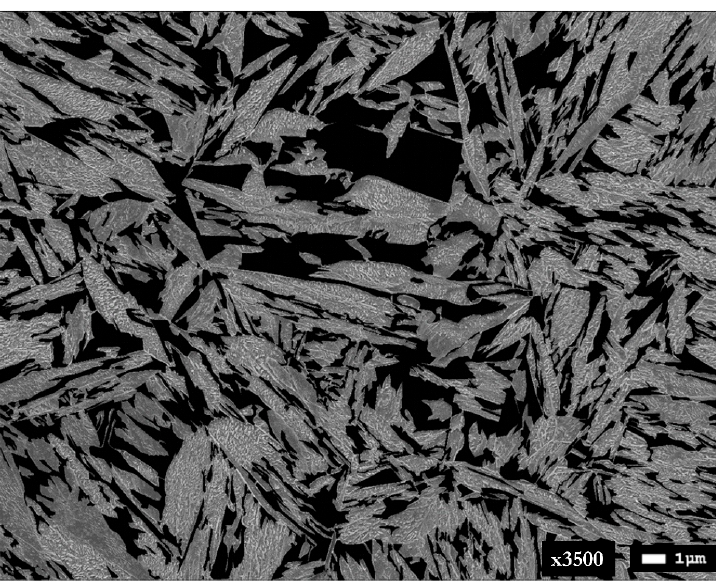
Figure 8. SEM image of the Q&P sample (QT = 230 °C PT/t = 400 °C/0 s) after having filled in black all the MA islands phases.